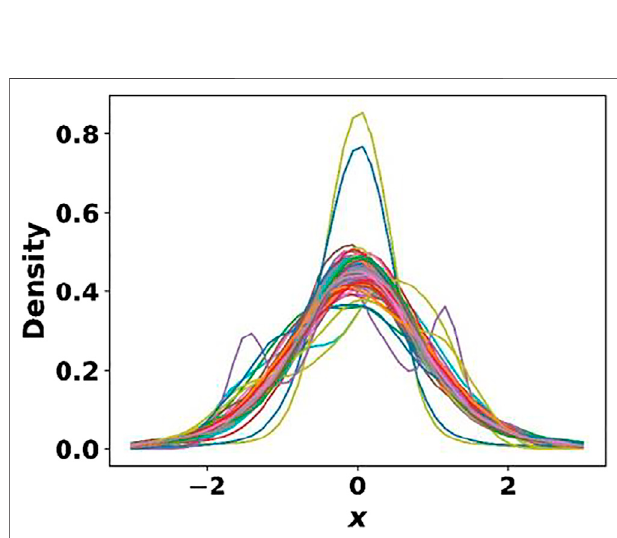
FIGURE7| Performanceofabasisautoencoderandasegmentationnetwork. (A) and (B) panelsshowa2Dsliceoftheinputandreconstructedbasisimagesfora material from the test set, respectively. (C) and (D) panels show the corresponding input and output elements matrices, respectively.